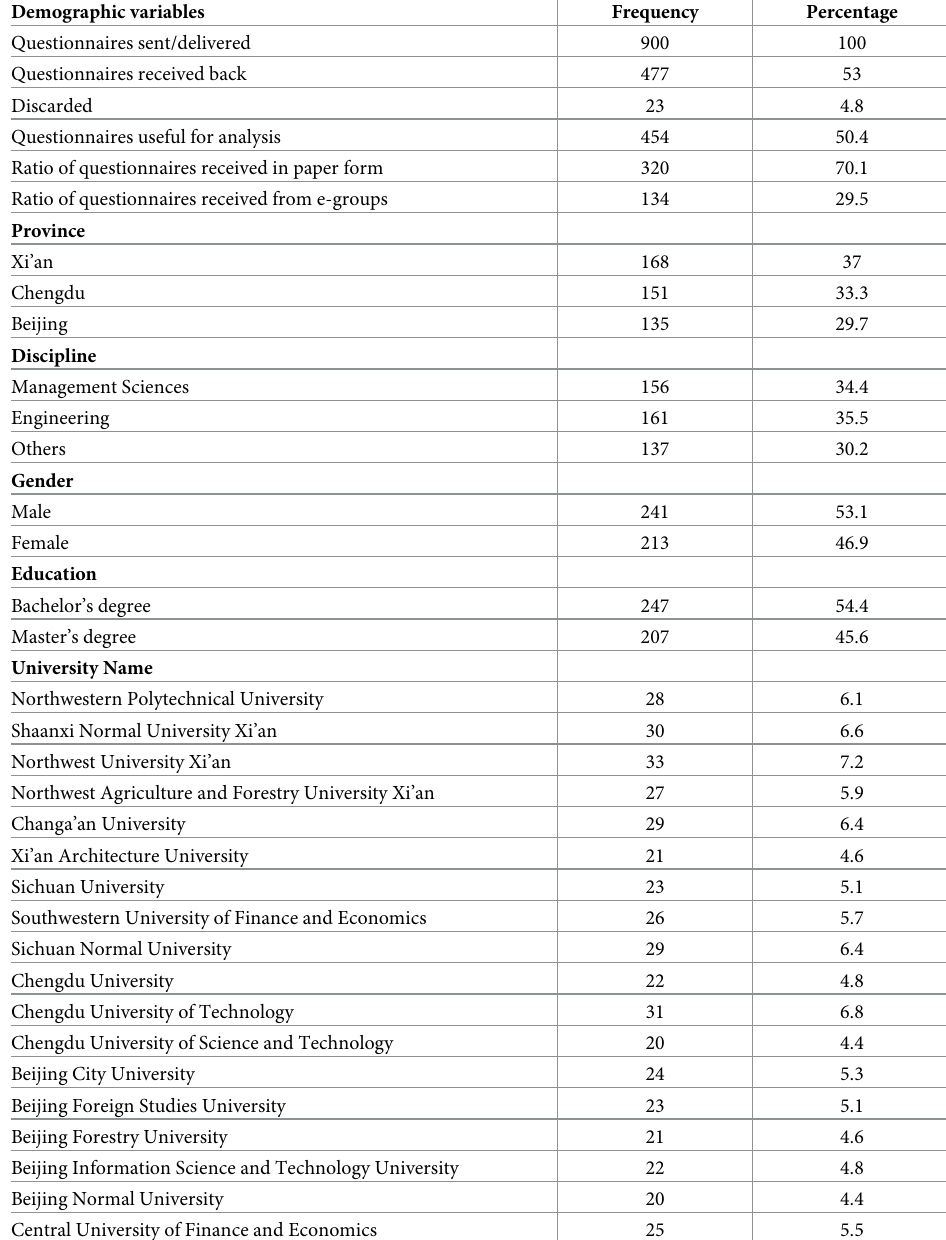
Table 1. Respondents’